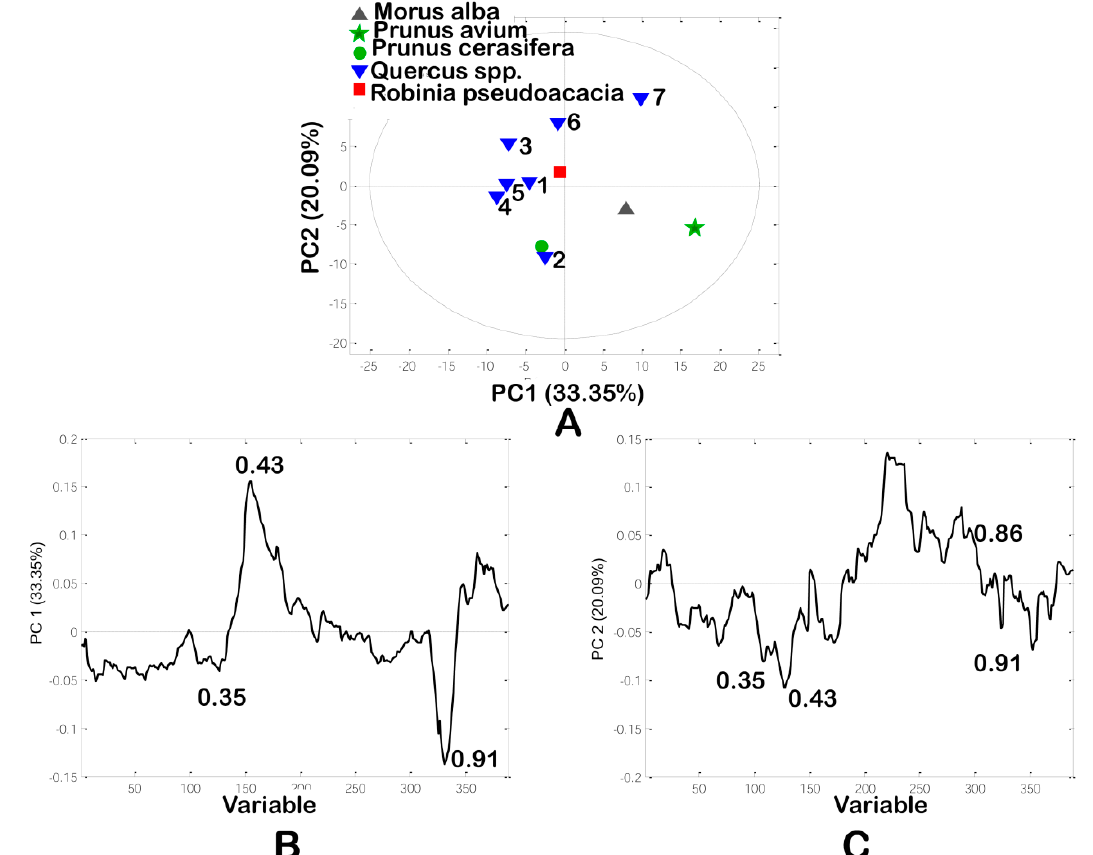
Figure 3. Principal component analysis ( PCA) of HPTLC chromatogram: ( A ) The PC score plot; ( B ) and ( C ) The loading plots. 1–3 Pedunculate oaks ( Quercus robur L.), 4–6 —sessile oaks ( Quercus petraea (Matt.) Liebl), 7—Turkey oak ( Quercus cerris L.).